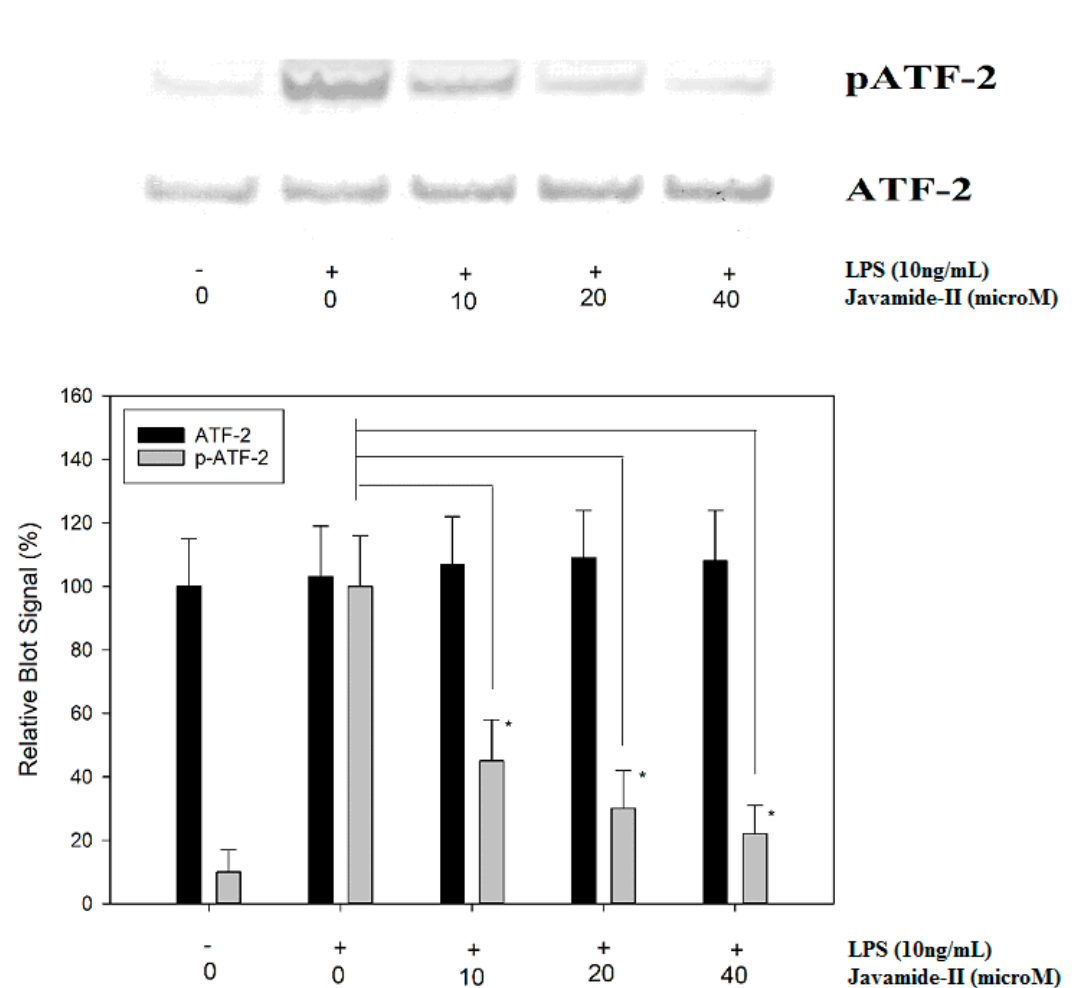
Figure 5. The effect of javamide-II on ATF-2 phosphorylation. PMA-differentiated THP-1 cells were treated with javamide-II (0, 10, 20, 40 µM) followed by treatment with LPS for 45 min, and the nuclear extract samples for blots were prepared as described in “Materials and Methods”. Data points represent the means ± SD ( n = 5). The P value was calculated using one-way ANOVA with the Holm–Sidak method, and the asterisks (*) indicate significant differences ( P < 0.05) compared to the ATF-2 controls.